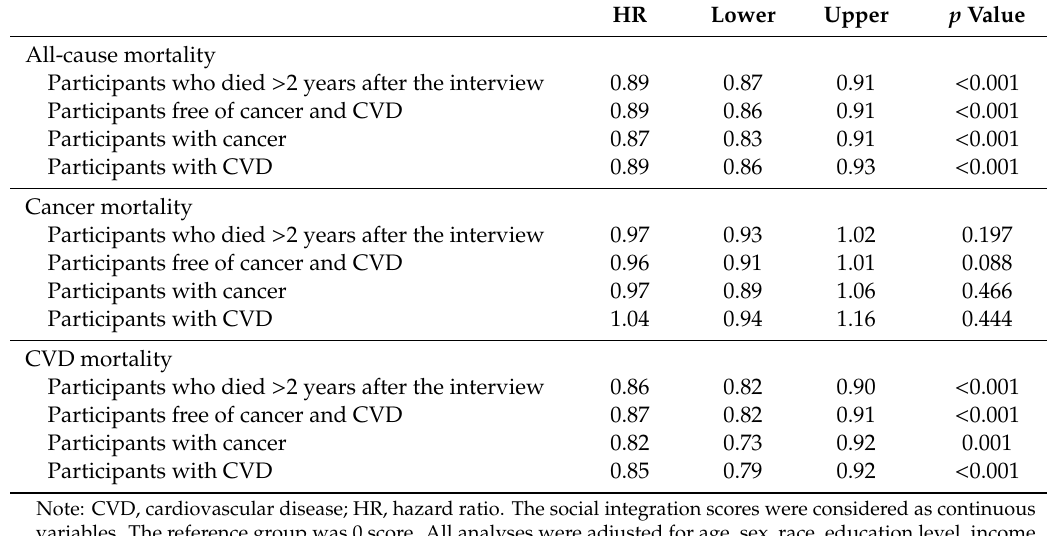
Table 6. Sensitivity analysis for hazard ratios for all-cause, cardiovascular, and cancer mortality by received social integration score. HR Lower Upper p Value All-cause mortality